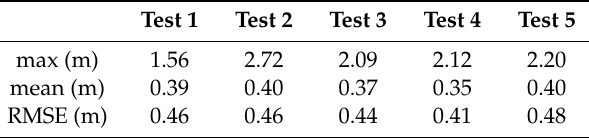
Table 7. 3D Positioning error.